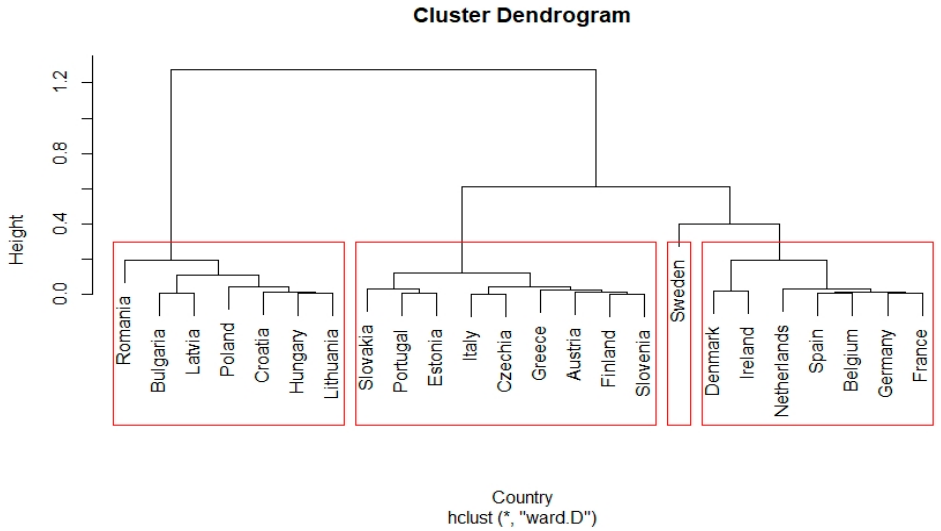
Figure 7. Cluster dendrogram of change of the efficiency of technology (TechCh) between years 2019 and 2013. and